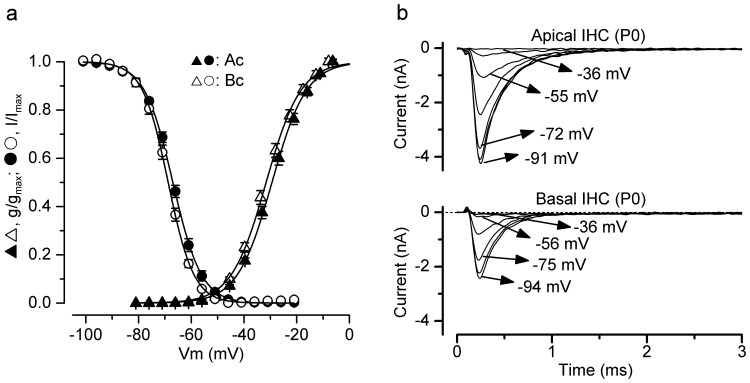
Activation and inactivation of the Na+ current in immature IHCs.
a, Normalized activation and inactivation curves from P0–P4 apical IHCs. Continuous lines are calculated from eqn. 3 (activation) and eqn. 4 (inactivation). Fitting parameters for the activation curves are: apical IHCs (n = 14) V
½ = −29.4 mV, S = 6.5 mV; I
max = −4289 pA; basal IHCs (n = 13) V
½ = −31.6 mV, S = 6.6 mV; I
max = −3198 pA. Fitting parameters for the inactivation curves are: apical IHCs (n = 12) V
½ = −67.0 mV, S = 5.4 mV; I
max = −4341 pA; basal IHCs (n = 10) V
½ = −68.8 mV, S = 4.9 mV; I
max = −2687 pA. b, I
Na was recorded from apical and basal P0 IHCs during 10 ms depolarizing test steps to −21 mV, following 50 ms conditioning steps (not shown) from −131 mV to −1 mV in 5 mV increments and used to derive the inactivation curves. Some of the conditioning steps are shown next to the traces. Apical and basal IHCs are as in Fig. 4a,b, respectively.